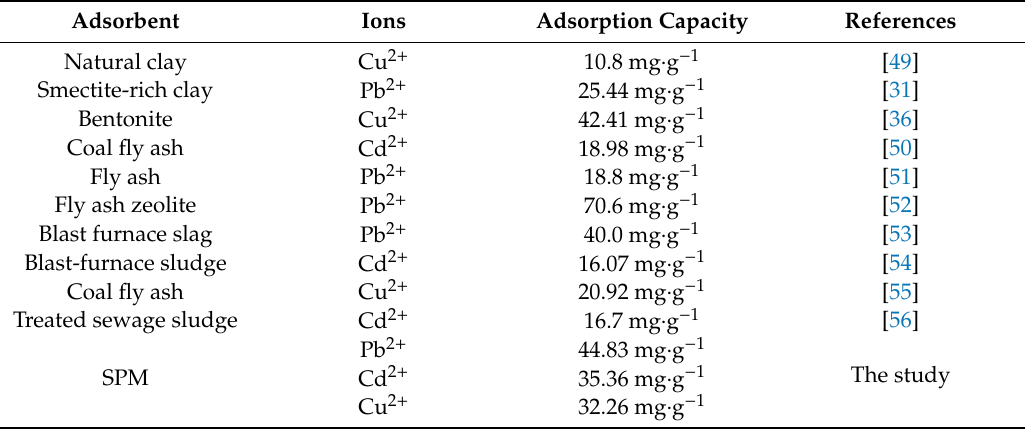
Table 4. Adsorption of metals on other silicate solid wastes.